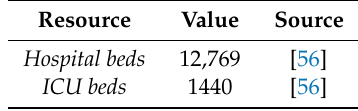
Table 3. Available hospital resources and target